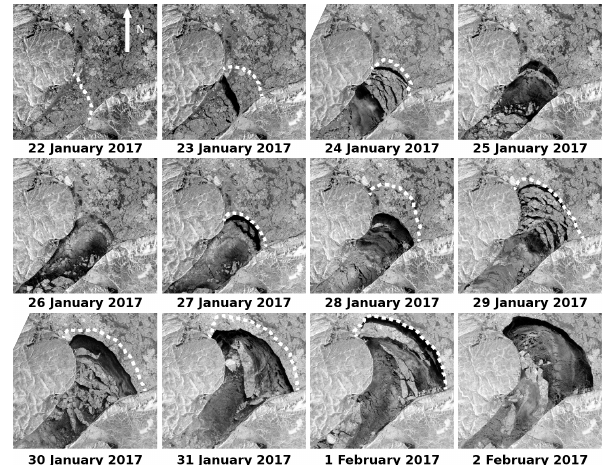
Figure 15. Daily Sentinel-1 images showing the development of the arch formation from 24 January 2017 until it matured on 2 Febru- ary 2017. The dotted line marks the arch shape and location in the following